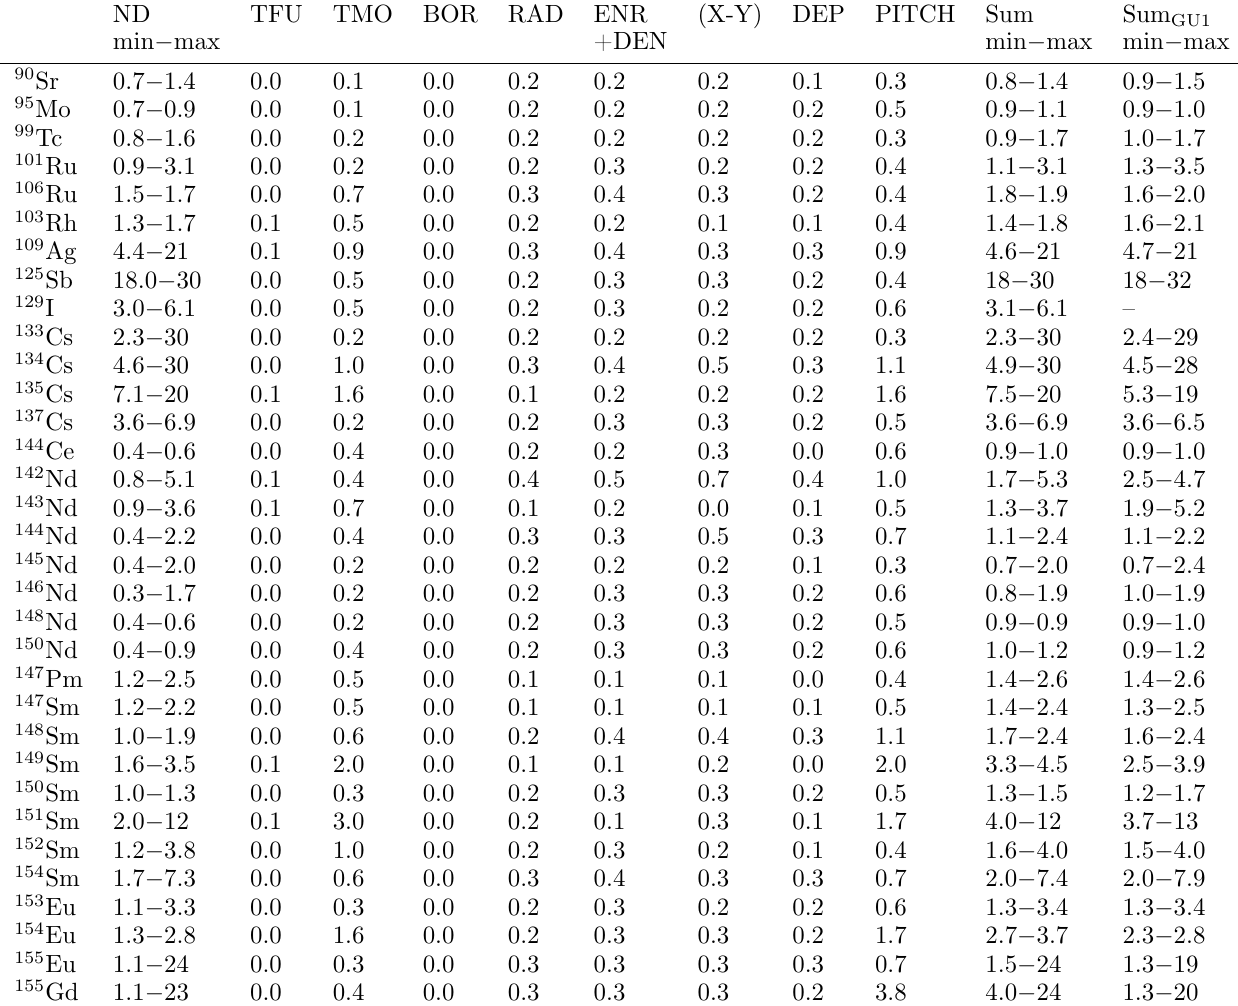
Table B.5. Same as Table B.4, but for fission